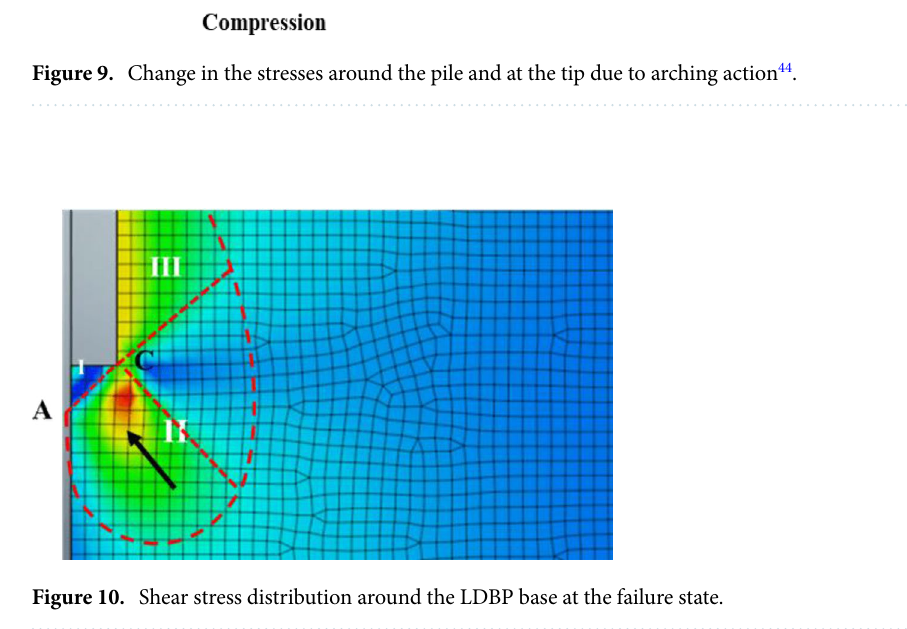
The ratio between horizontal and vertical stresses Ø ′ around the pile base under failure load (K)